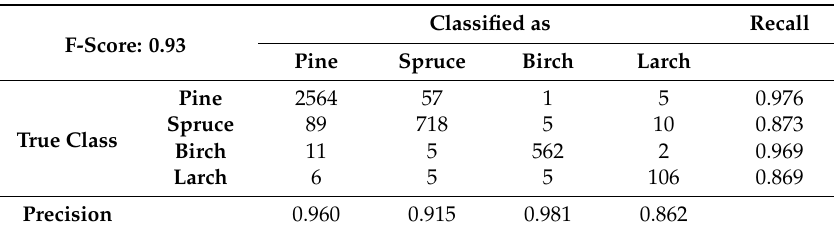
Table 16. Confusion matrix of classification using MLP with a feature-selected data set selected from all features. F-score presents the mean F-score for all species.